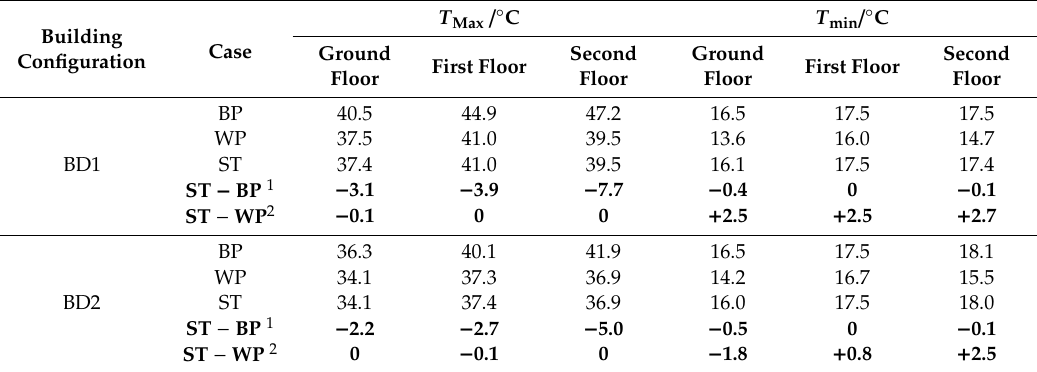
Table 7. Average maximum indoor temperature ( T Max ) over the hottest week of the year and average minimum indoor temperature ( T min ) over the coldest week of the year, for a building painted with an optimized thermochromic step transition paint (ST), in Abu Dhabi, United Arab Emirates.